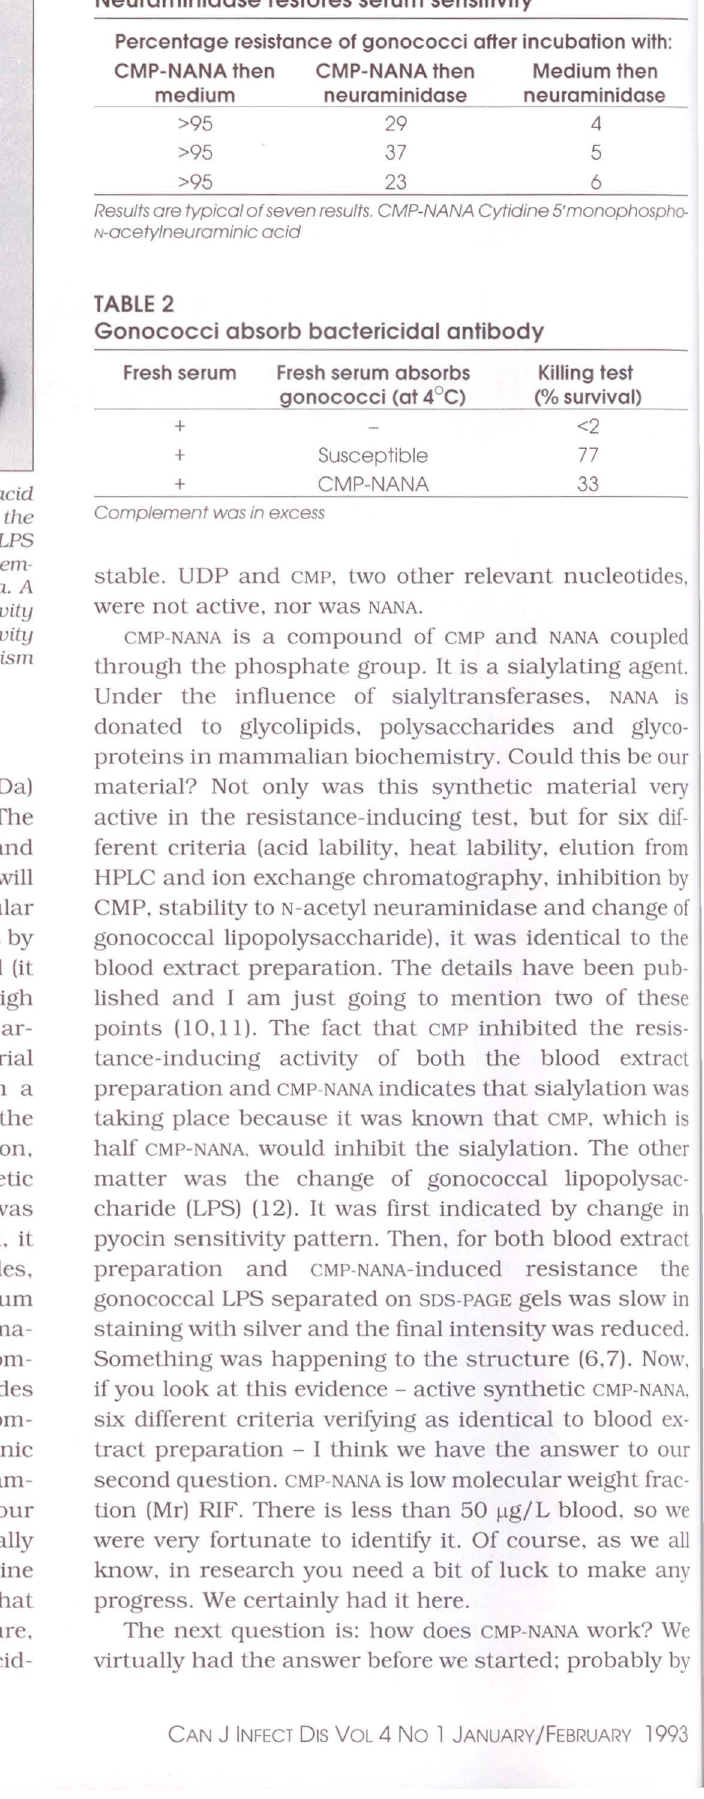
Neuraminidase restores serum sensitivity Percentage resistance of gonococci after incubation